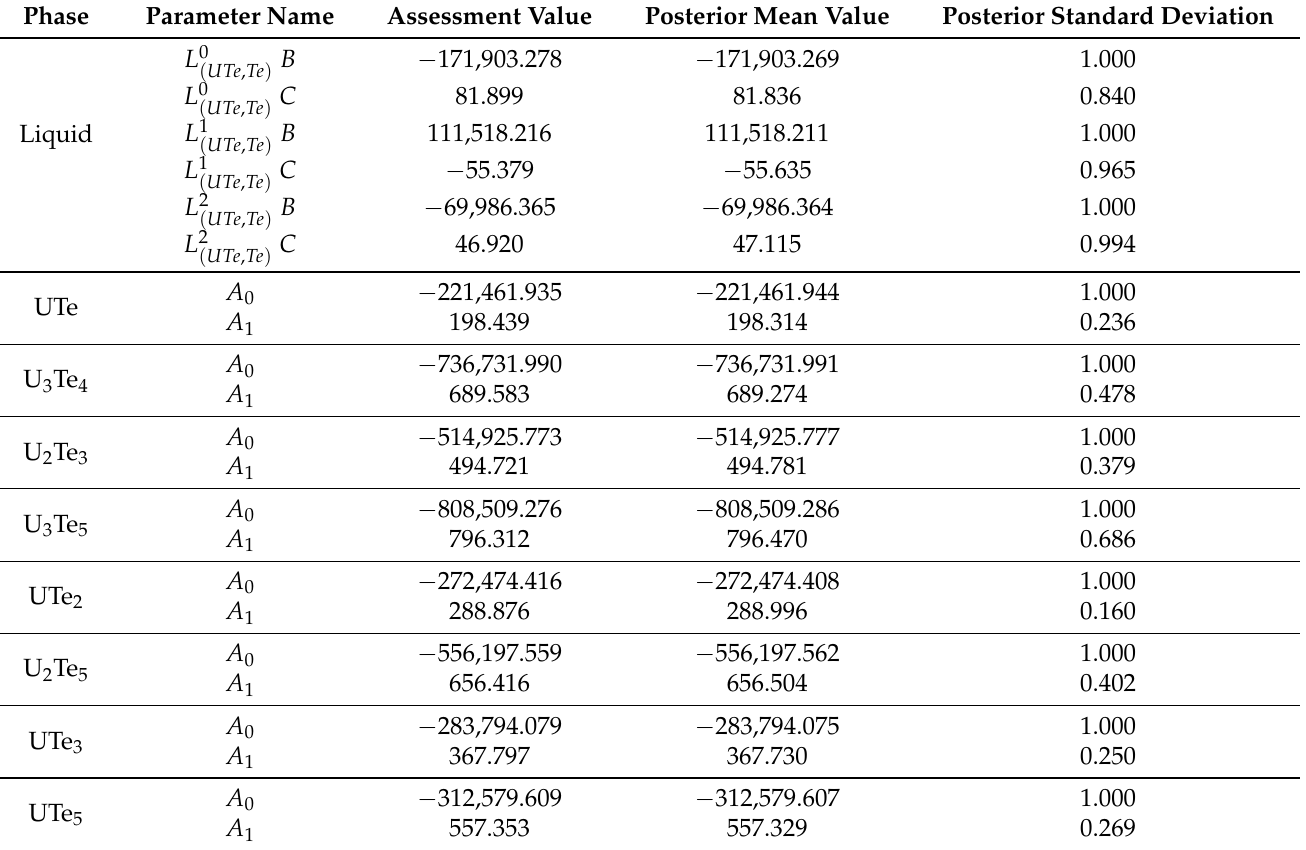
Table 4. Posterior mean and standard deviation of the U–Te system parameters. The correlation matrix of the system parameters can be found in Appendix